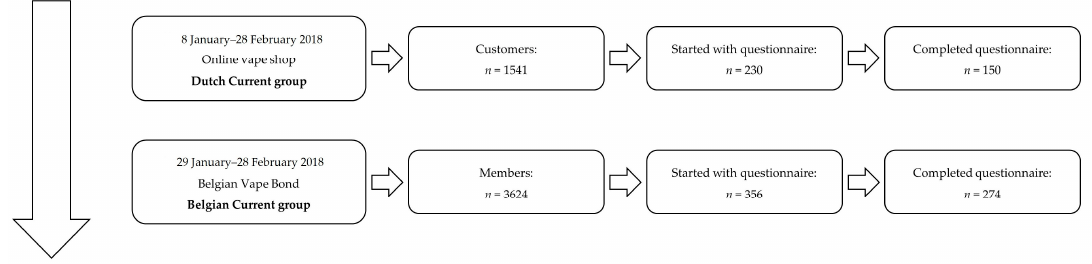
Figure 1. Flowchart of recruitment of participants.